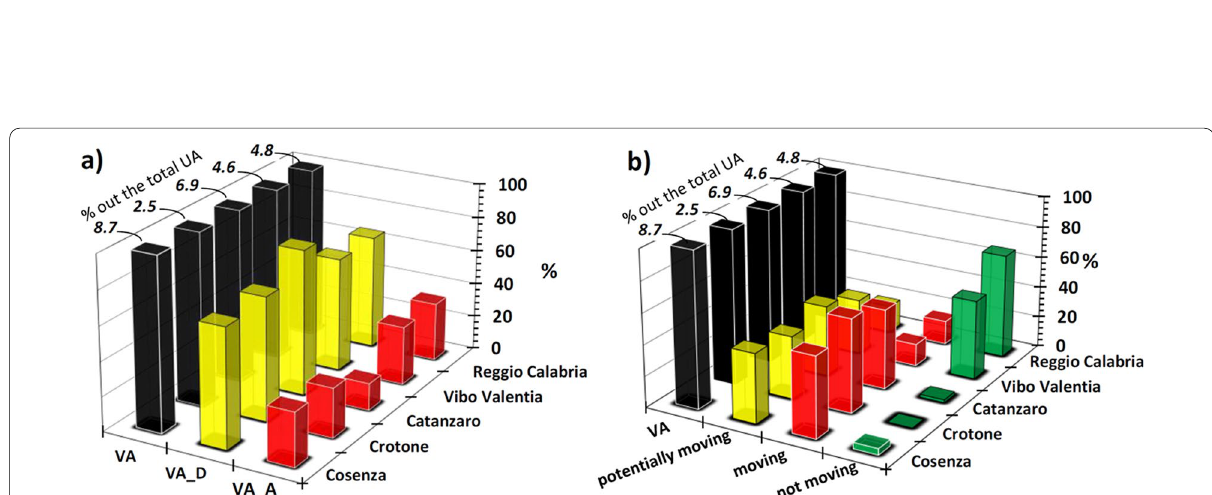
Fig. 10 Percentages of VA s (out of the total UA) recorded within the five administrative Provinces of the Calabria region distinguished according to a “ active ” (VA_A) and “ dormant ” (VA_D) vulnerable areas on the basis of the landslide state of activity (LSA) and b “ potentially moving ”, “ moving ” and “ not moving ” vulnerable areas on the basis of the Index of DInSAR-based movement (I DM )